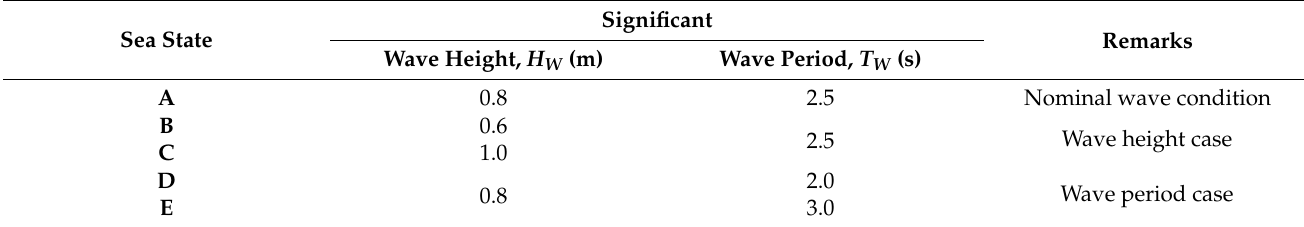
Table 3. The parameters of five different sea states.